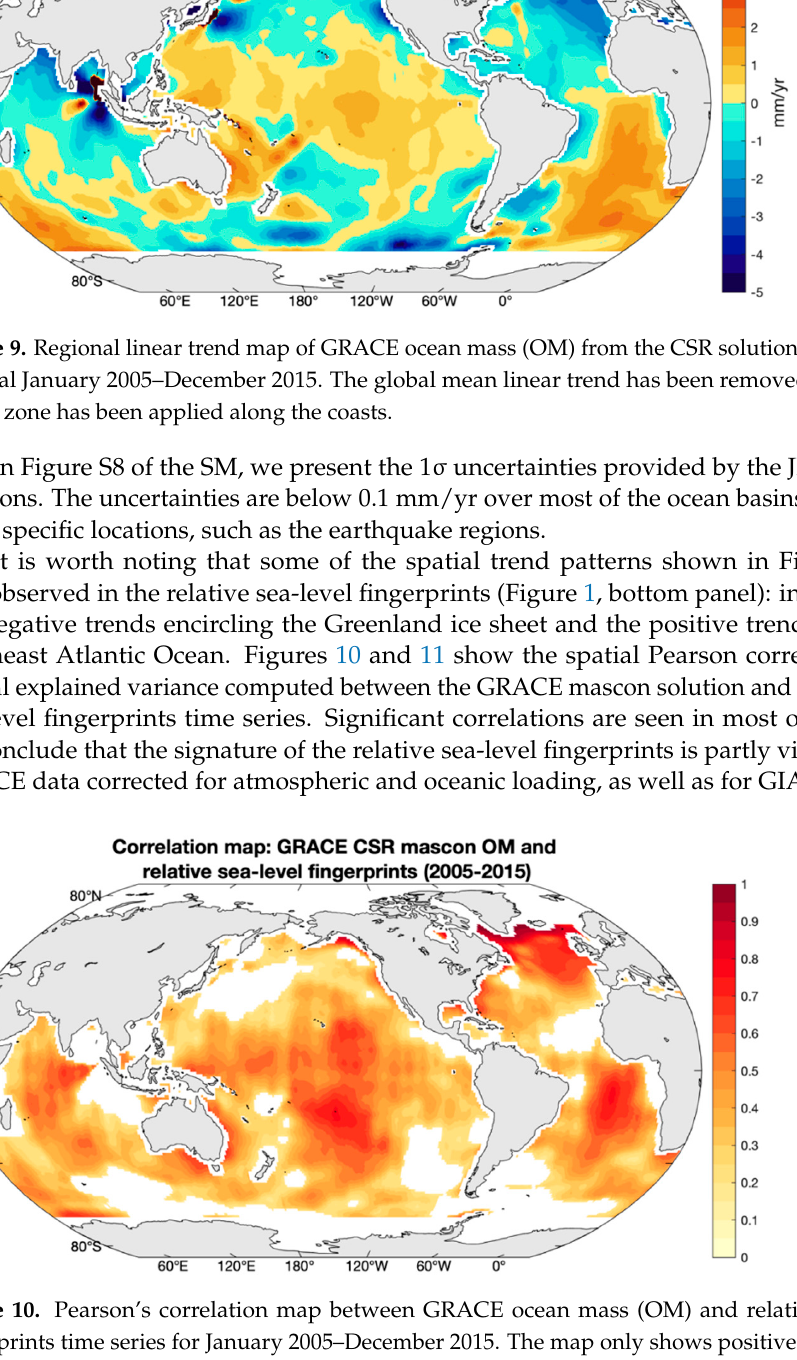
Figure 9. Regional linear trend map of GRACE ocean mass (OM) from the CSR solution for the time interval January 2005–December 2015. The global mean linear trend has been removed. A 200 km buffer zone has been applied along the coasts.